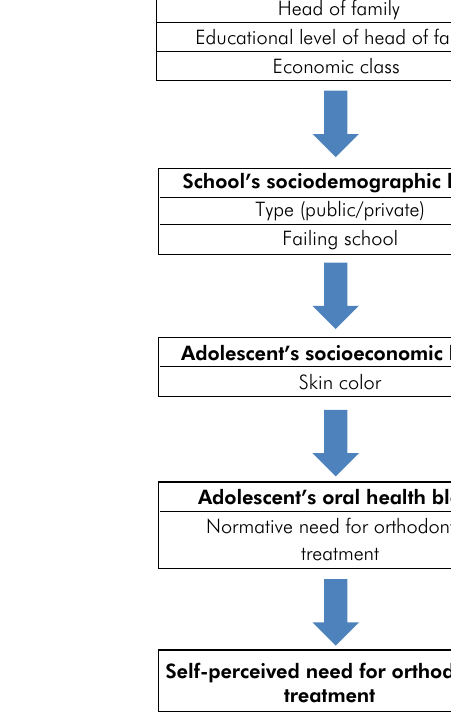
Figure. Theoretical model of the sociodemographic determination of adolescents’ oral